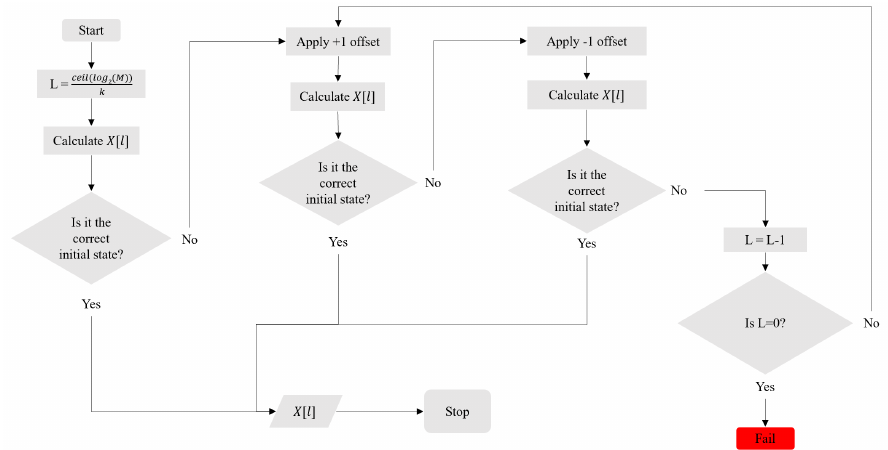
Figure 16. A flow diagram showing the modified RNS attack algorithm when a single error is present.